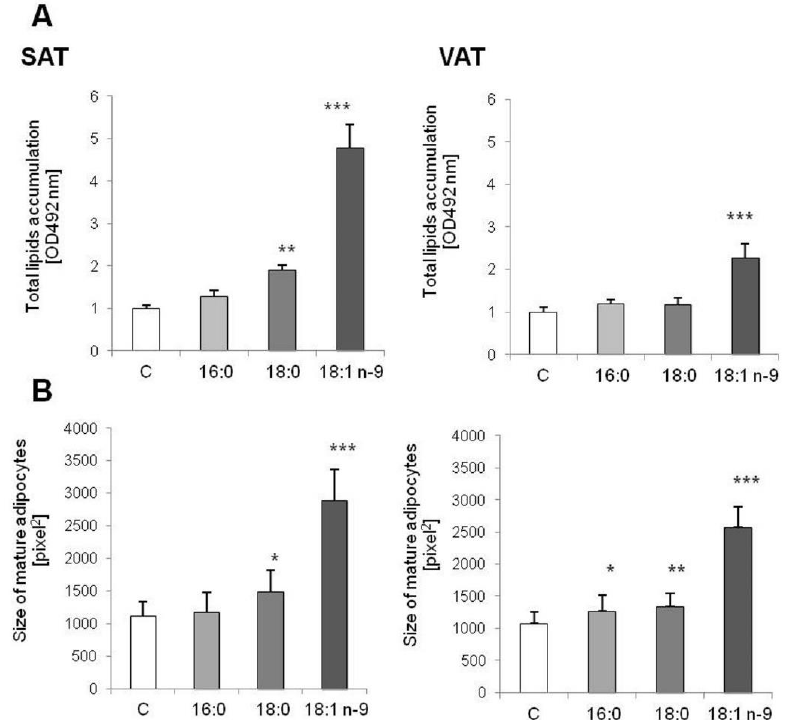
Figure 2. Total lipid content accumulated during adipogenesis in control and experimental